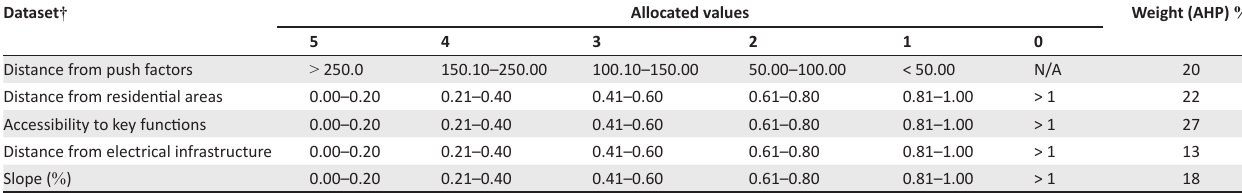
TABLE 2: Residential suitability.